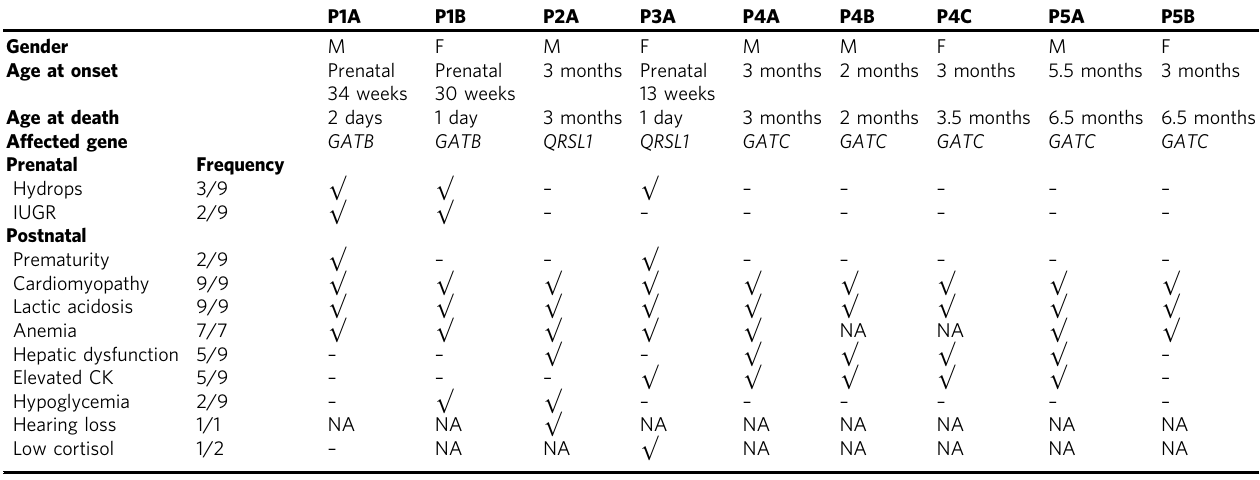
Table 1 Symptoms of patients with de fi cient GatCAB